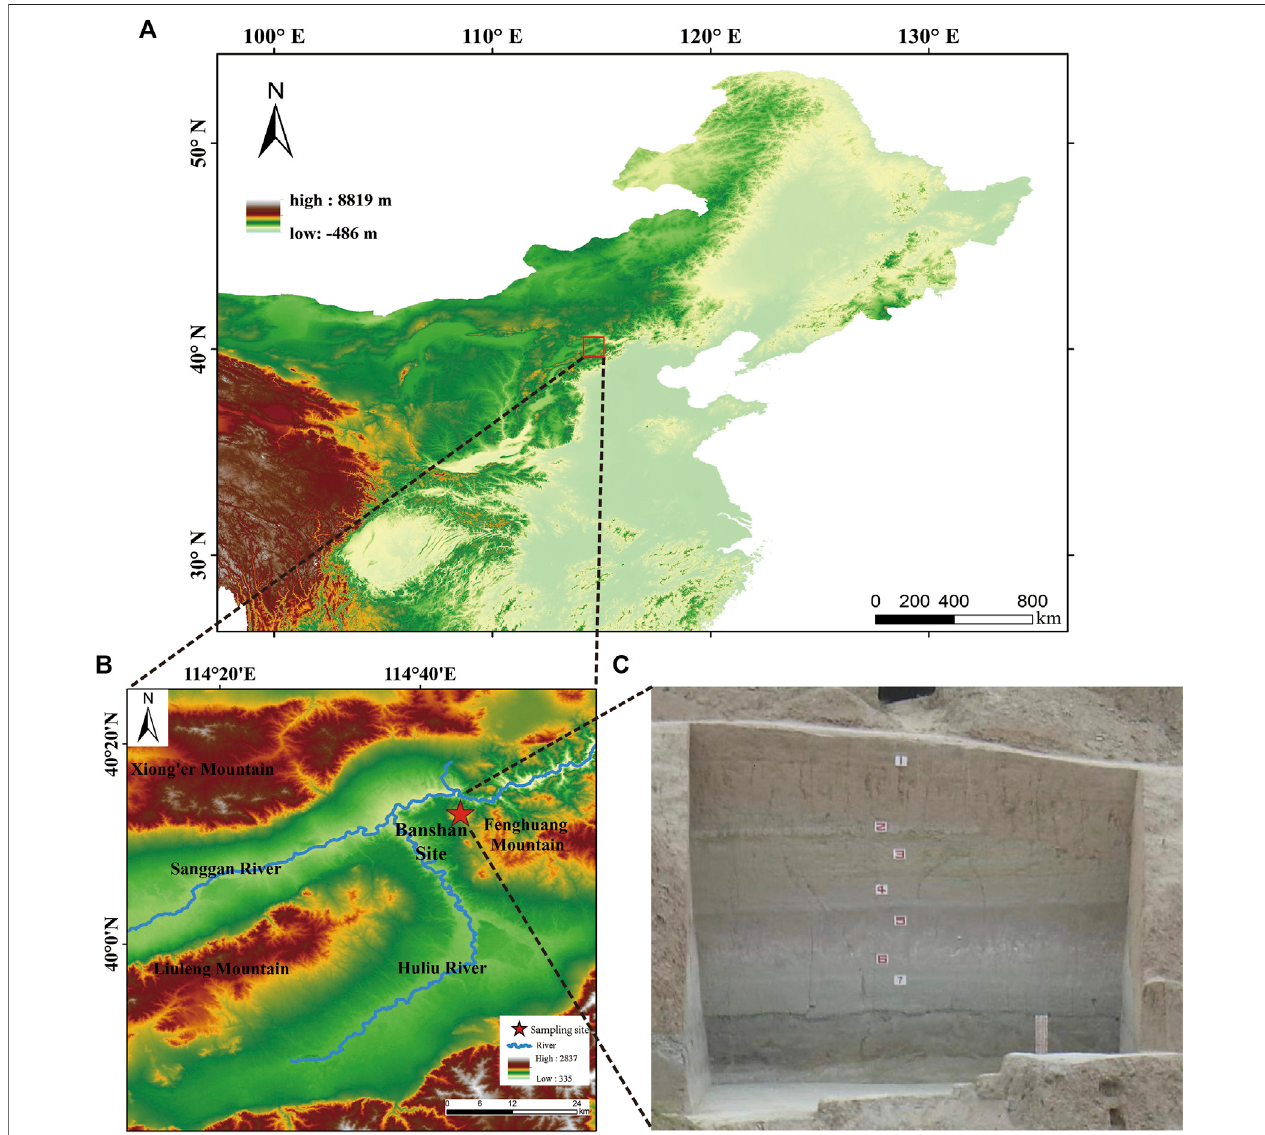
FIGURE 1 | Location of the Nihewan Basin in China (A) . The topography of the study area together with the location of the sampling site (B) and the fi eld photograph of sampling site (C) . (Altitudes are in m a.s.l.).